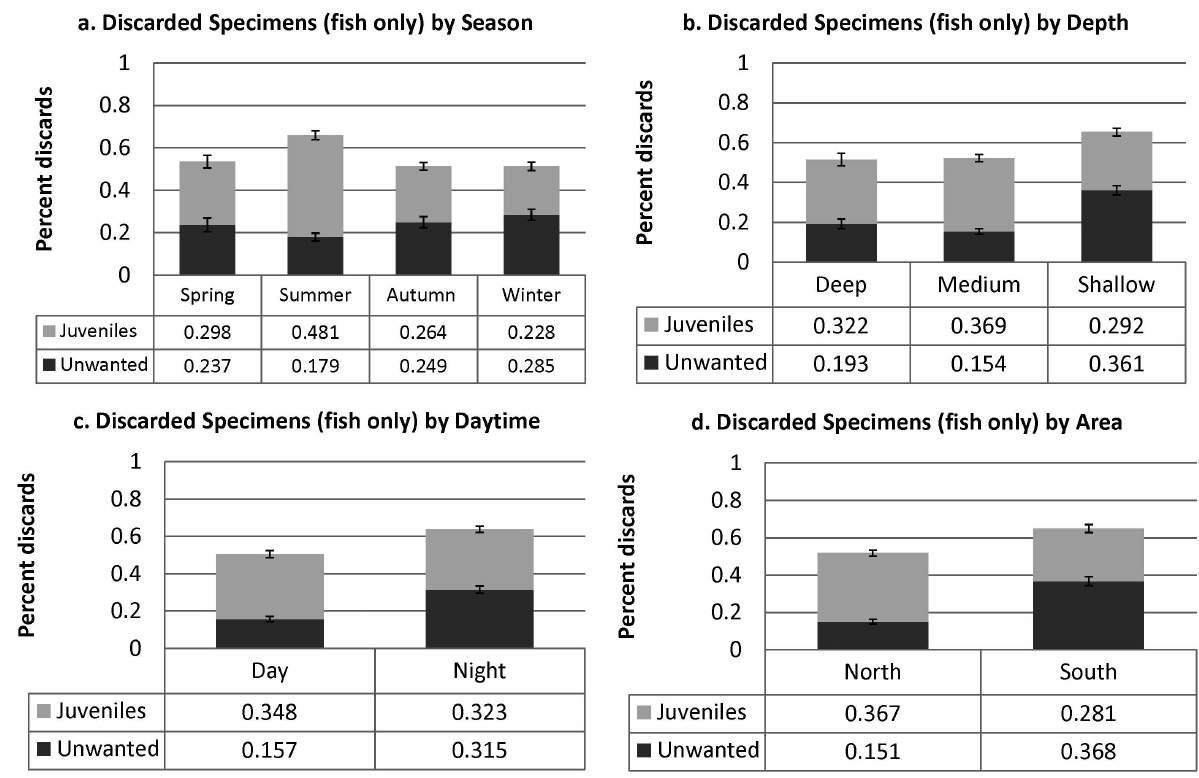
Fig . 4. – Mean proportion of the two fractions comprised in the discarded portion of the fish in 324 haul samples: undersized juveniles of commercial species and specimens of unwanted, non-commercial species ± standard error, for the 4 study factors: a, season; b, depth; c, time of day; and d, area.